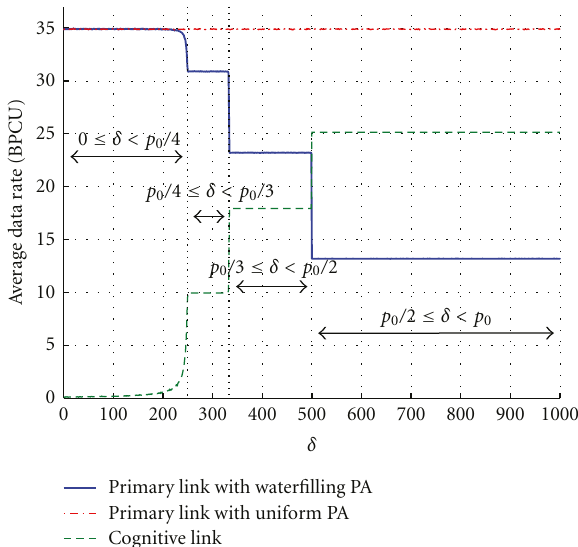
Figure 3: Average data rate for both the primary and the secondary networks versus SNR for di ff erent numbers of antennas; M = 2,4,6,8, and δ = p 0 /M .